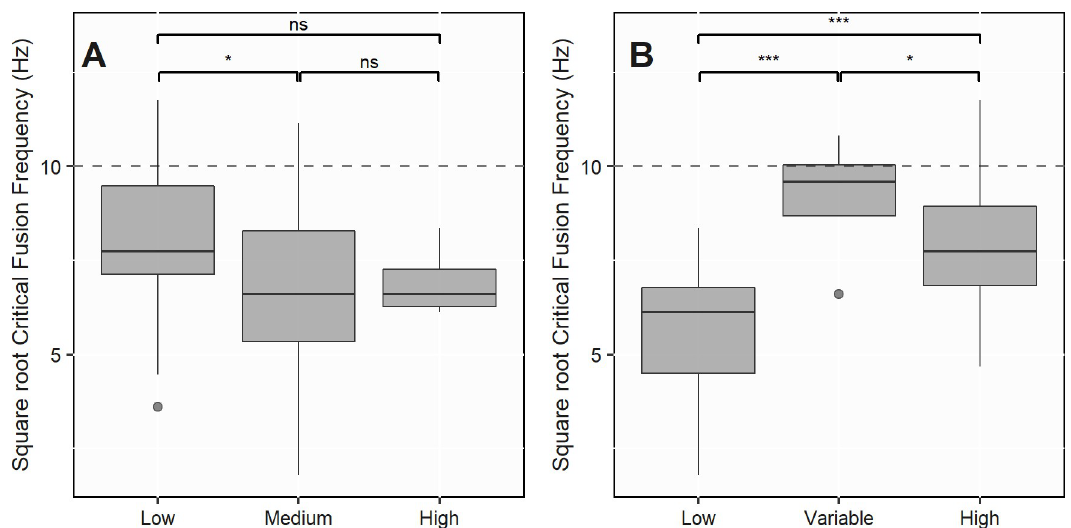
Fig 4. Square root Critical Fusion Frequencies (CFF) for (A) low, medium and high risks of bias and for (B) low, variable and high light exposure levels. The dashed line represents the flicker frequency of a lamp on a 50 Hz electrical supply—i.e. 100 Hz. Sample size: (A) Low (n = 20), Medium (n = 55), High (n = 4); (B) Low (n = 30), Variable (n = 4), High (n = 45). Linear mixed effect model differences are indicated as follows: ��� p-value < 0.001, �� p-value < 0.01, � p-value < 0.05, ns non